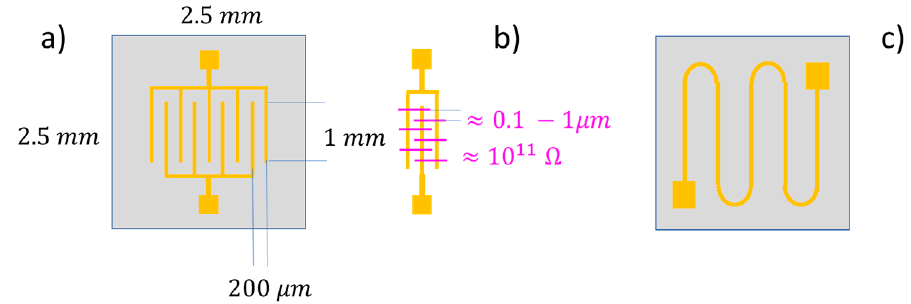
Figure A1. Electrical readout of SLV-deposited SnO 2 nanowires: ( a ) Interdigital Pt electrodes; ( b ) SnO 2 nanowires bridging Pt electrodes; ( c ) back-surface Pt heater meander.